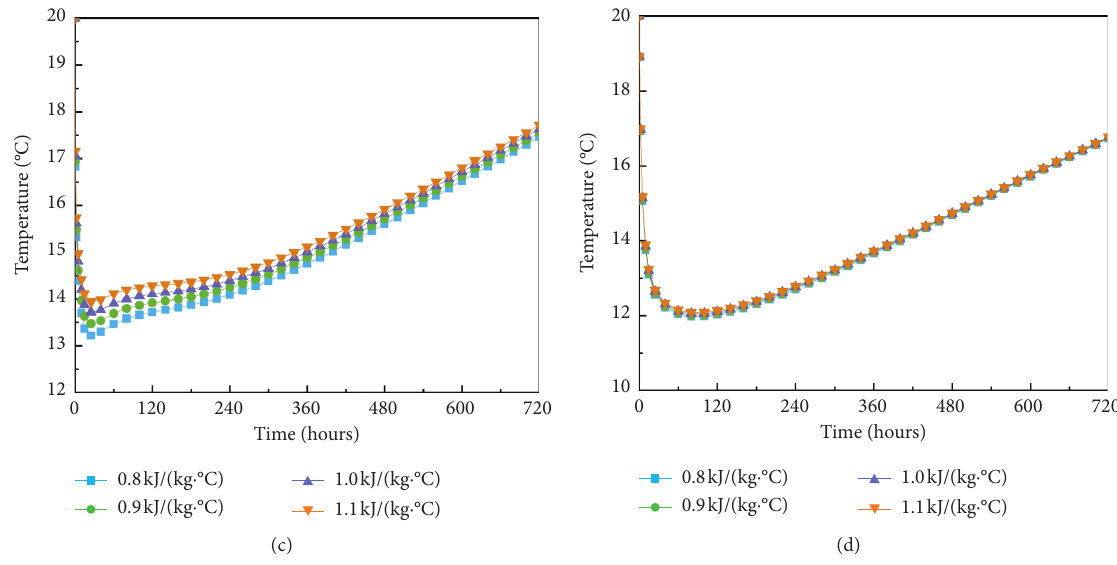
Figure 6: Temperature-time curves with different specifics heat. (a) Point A, (b) point B, (c) point C, and (d) point D.